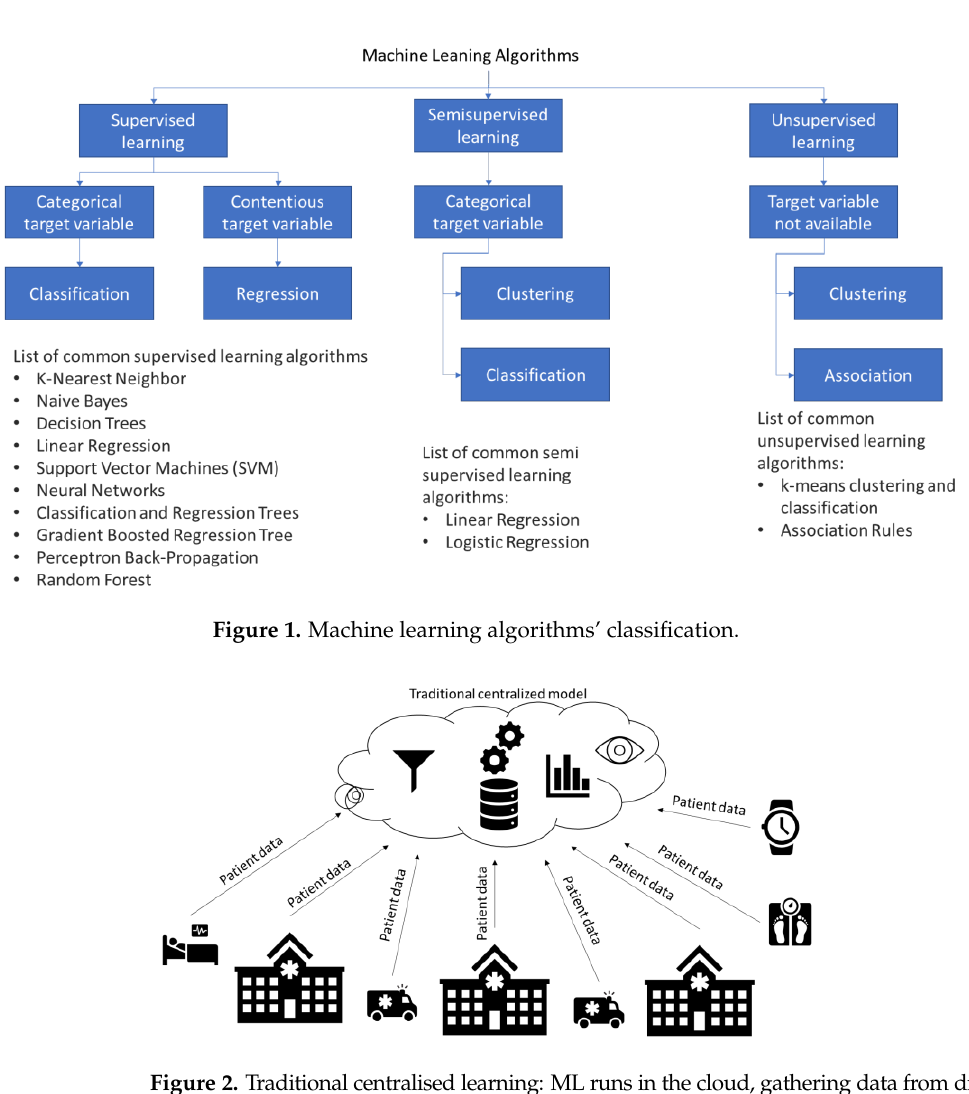
Figure 2. Traditional centralised learning: ML runs in the cloud, gathering data from different hospitals.